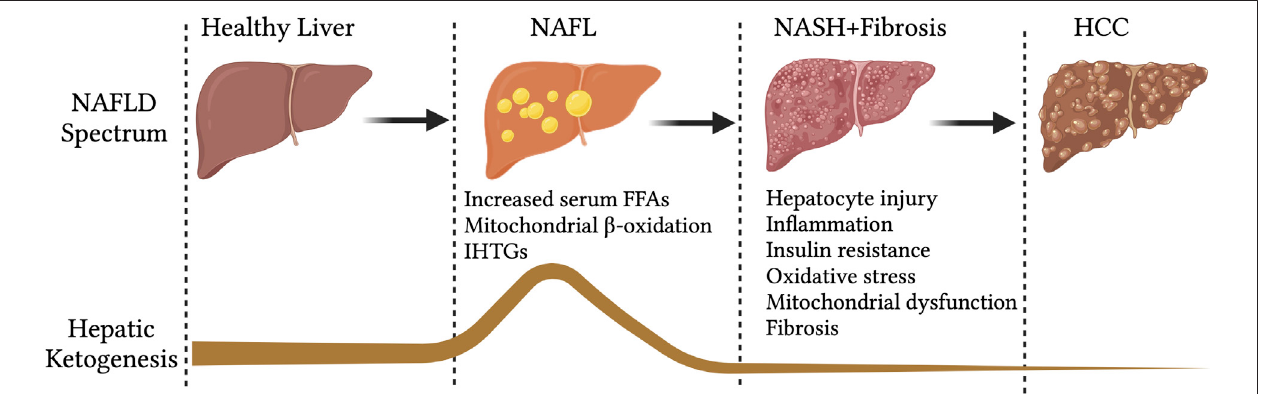
FIGURE 2 | Hepatic ketogenesis status during the development of NAFLD to HCC. During the spectrum of NAFLD, the hepatic ketogenesis was augmented in response to entry of fatty acids into the liver. However, as the NAFLD progress to NASH, fi brosis and HCC, the ketogenesis was signi fi cantly impaired. Abbreviations: